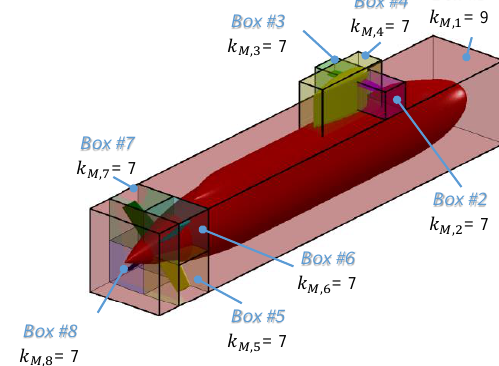
Figure 6. The segmented model with geometry-based boxes